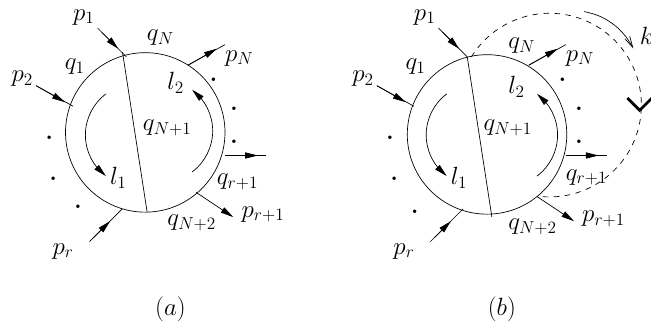
Figure 5 . (a) Two loop graph; (b) same graph with causal ordering of two